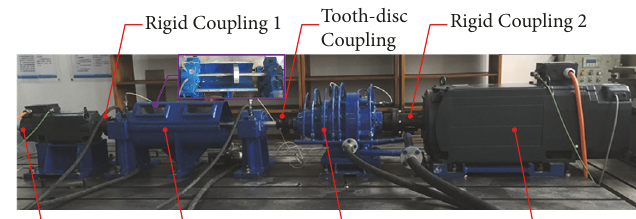
Figure 12: Experimental setup.